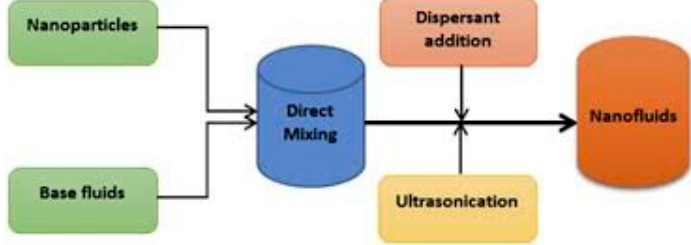
Figure 1. Block diagram for the development of nanofluid. Table 1. Characteristic features of Al 2 O 3 nanoparticles.